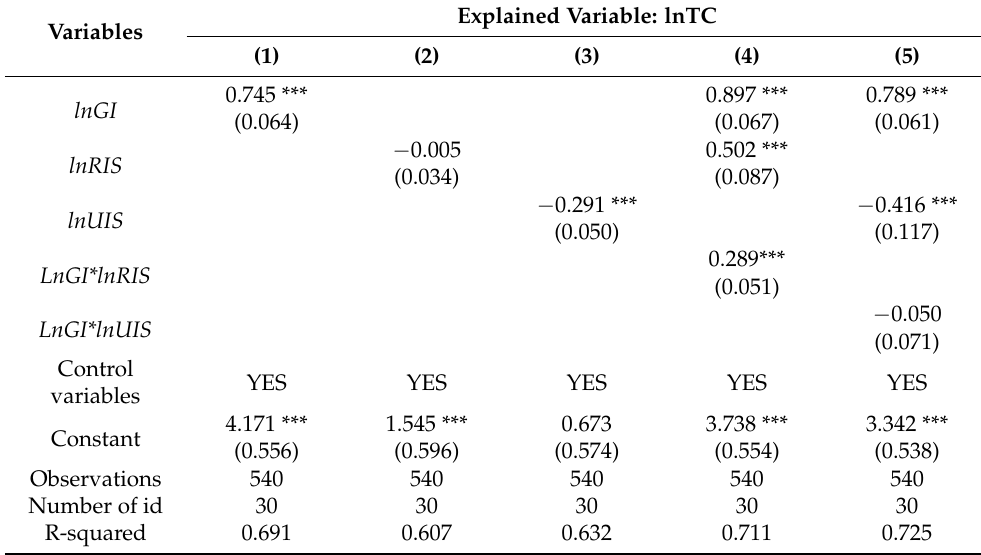
Table 5. Regression results for the robustness of the substituted explained